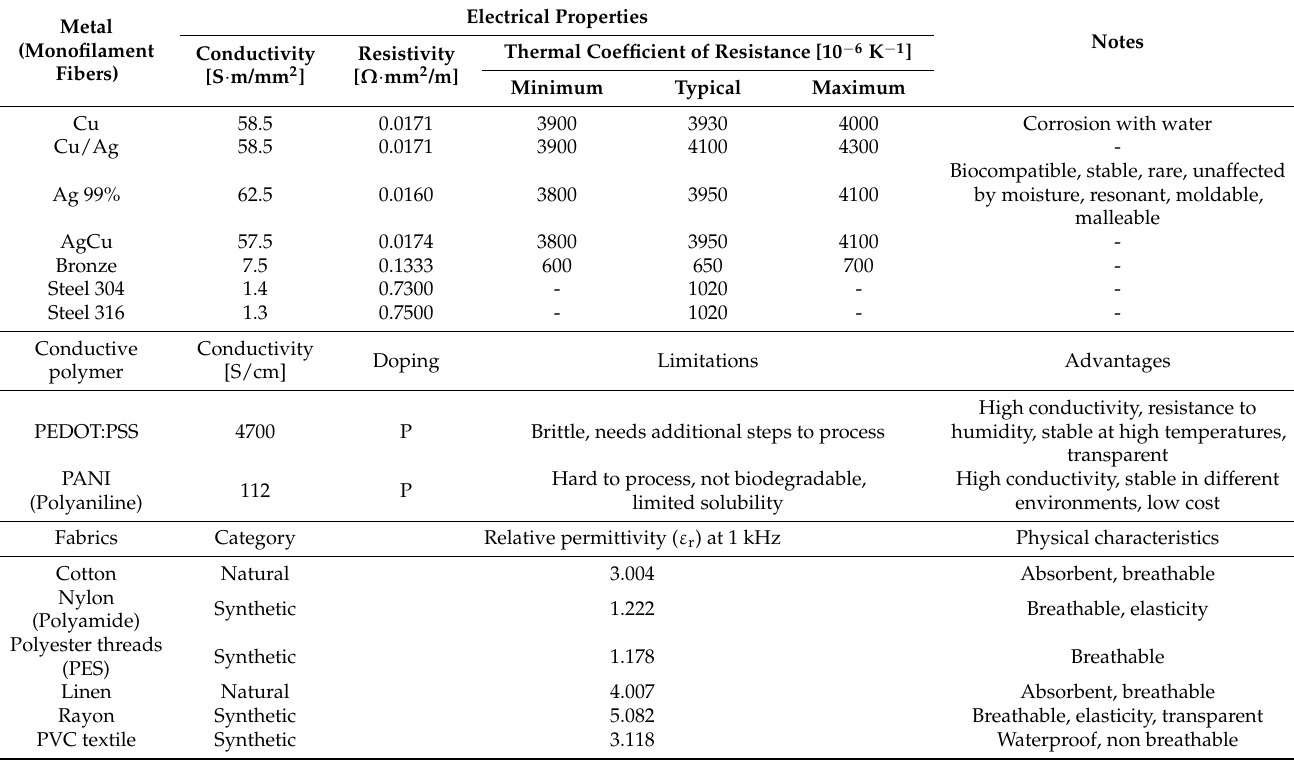
Table 2. Materials used to manufacture e-textiles